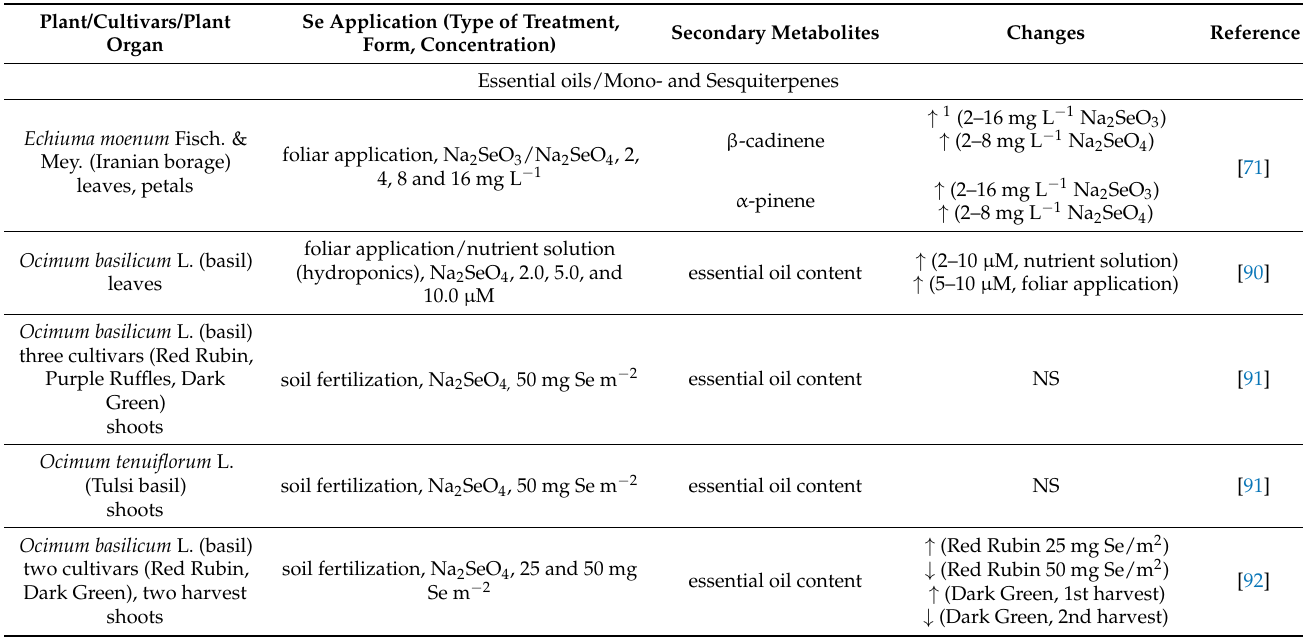
Table 2. Effect of Se application on the accumulation of